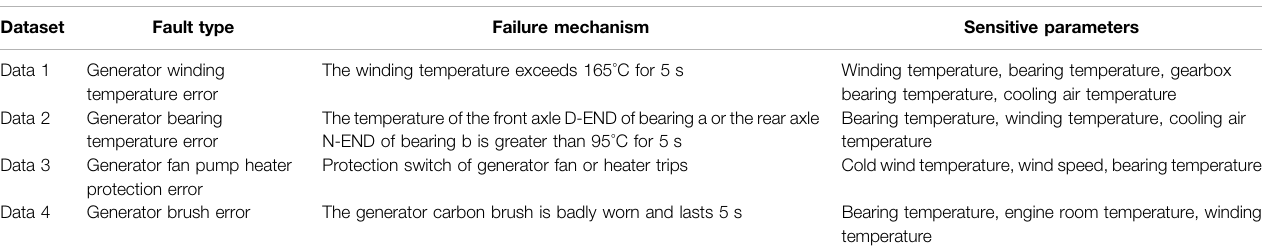
TABLE 2 | Wind turbine generator fault type and sensitive